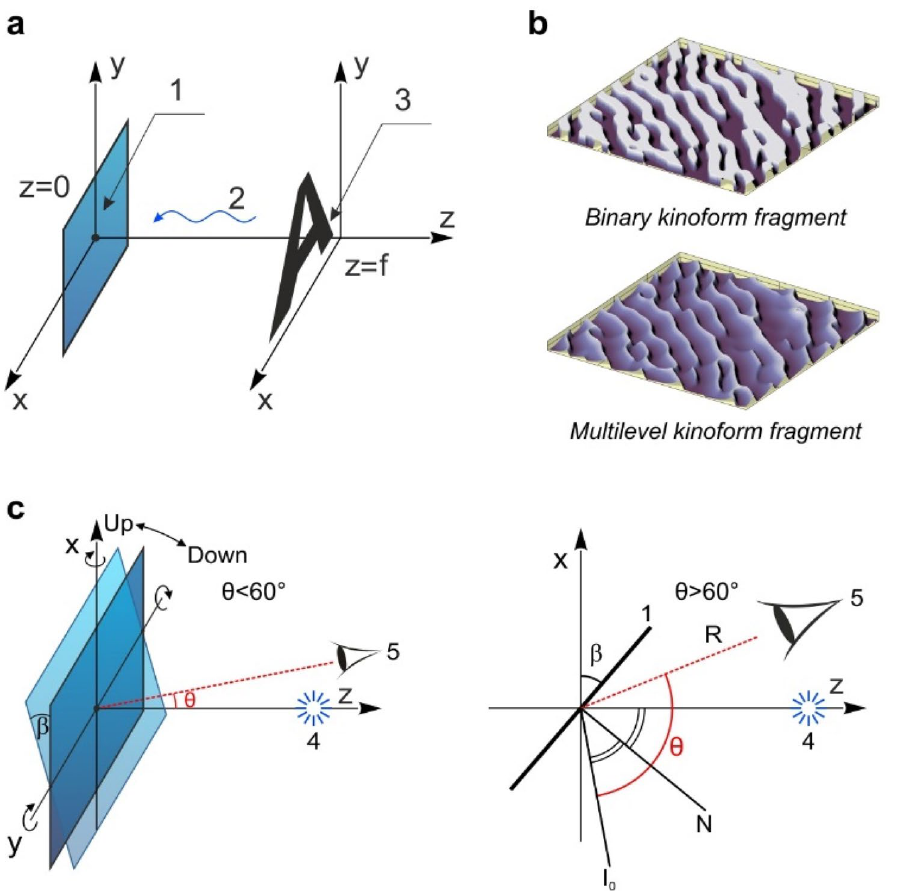
Figure 1. Formation of images using kinoforms. ( a ) Image formation scheme used to compute the phase function of the kinoform that forms the given image. ( b ) Fragments of a binary and a multilevel kinoform. ( c ) Observation schemes of the DOE at diffraction angles θ < 60° and θ >